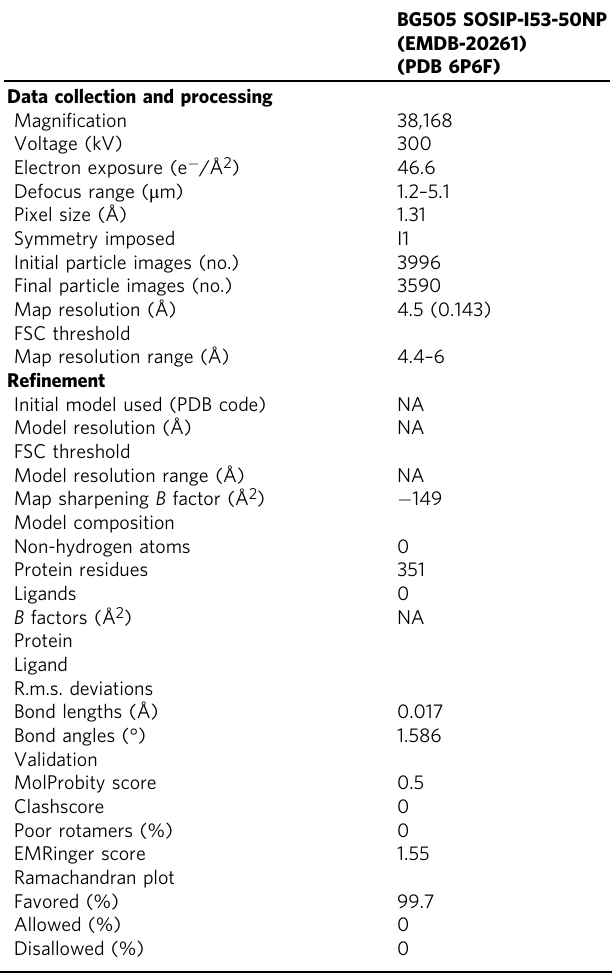
Table 2 Cryo-EM data collection, re fi nement, and validation